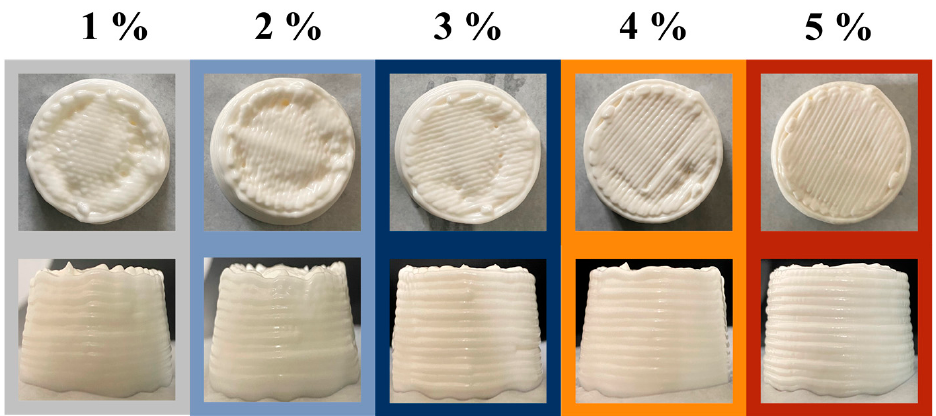
Figure 6. The visual appearance of 3D printed samples of HIPEs stabilized by 1–5 wt%